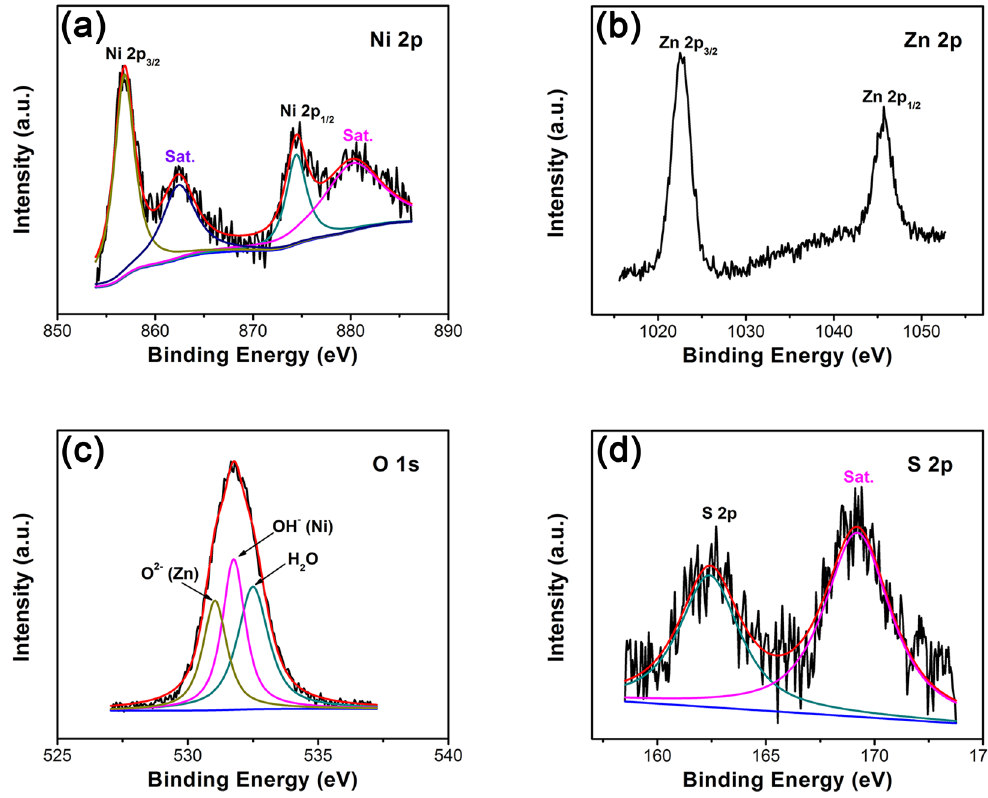
Figure 2. XPS spectra of the NZZN-4 mmol sample in the energy regions of ( a ) Ni 2p, ( b ) Zn 2p, ( c ) O 1 s and ( d ) S